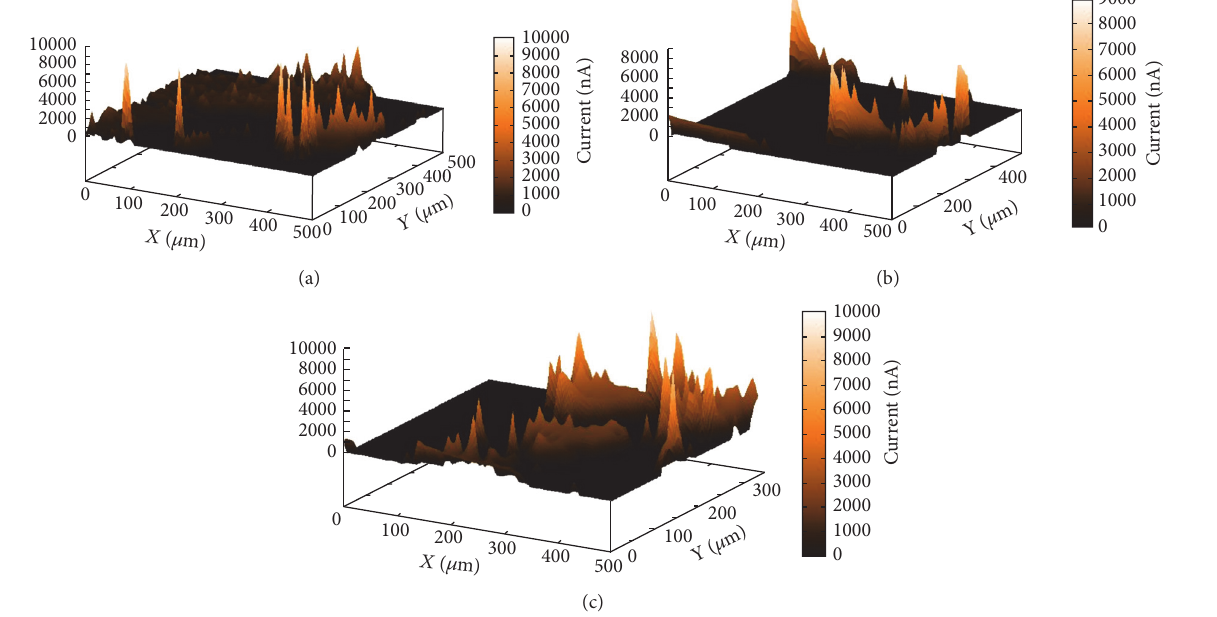
Figure 1: Analysis of electrochemical sweep microscopy of electrode surface (a) GC/CNT; (b) GC/CNT/Bi; and (c) GC/CNT/Hg.